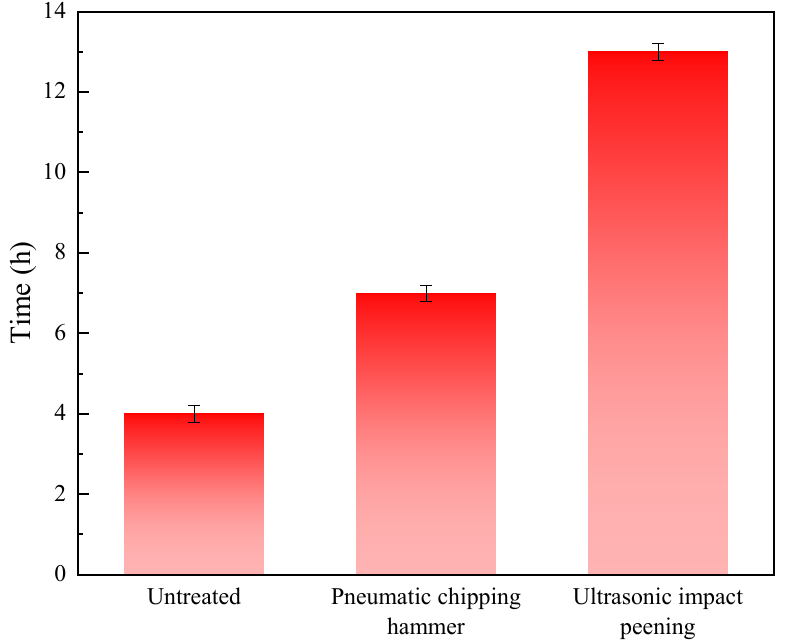
Figure 7. Stress corrosion cracking time of the welded joints with different treatment methods.